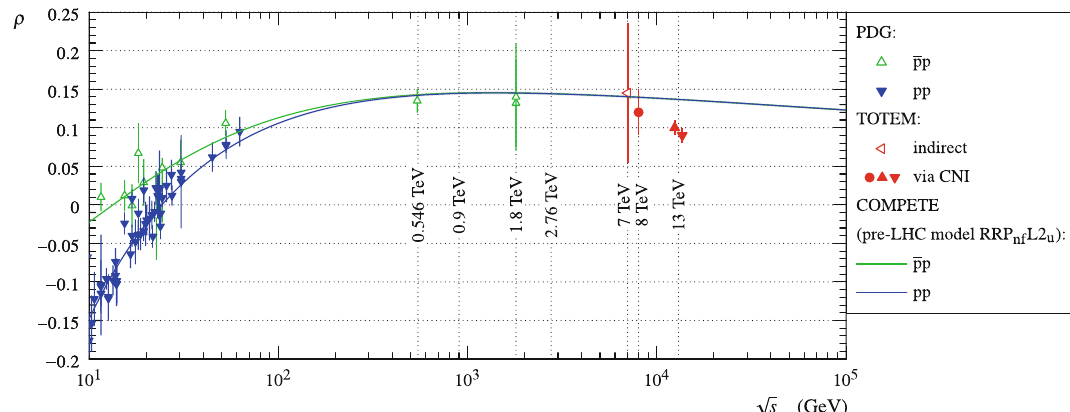
Fig. 16 Dependence of the ρ parameter on energy. The pp (blue) and p ¯ p (green) data are taken from PDG [45]. TOTEM measurements are marked in red. The two points at 13TeV correspond to the two